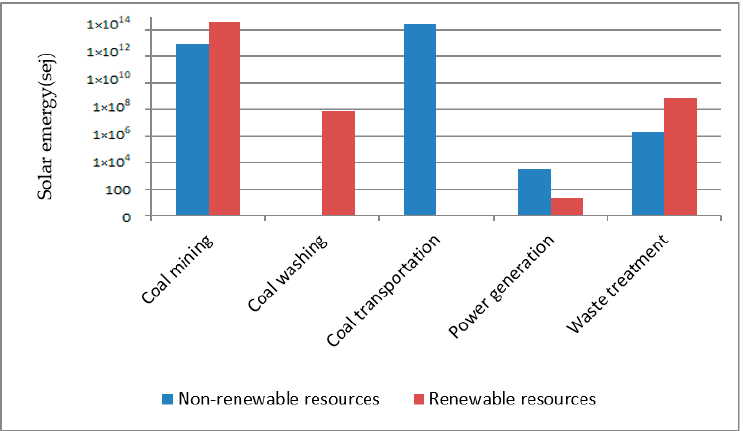
Figure 3. Life Cycle renewable and non-renewable resource consumption (×10 11 ).